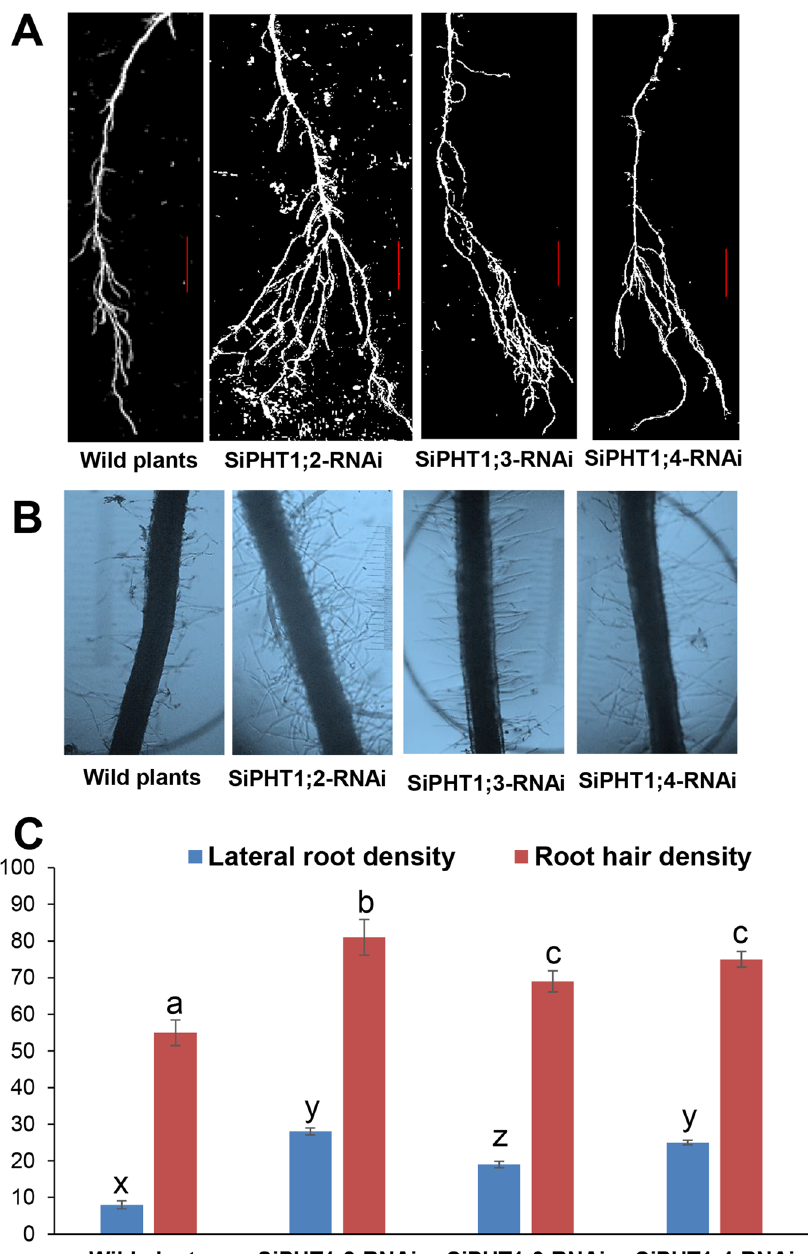
Figure 6. Analysis of root morphology in the 3 RNAi lines and wild plants grown under low Pi (10 µ M) on hydroponics. Whole root images showing the lateral root formation in wild type and 3 RNAi lines grown after 4 weeks ( A ) (bar = 1 cm), root hair images of wild type plant and 3 RNAi lines after 4 weeks of growth ( B ), measurement of lateral root density per cm of root and root hair density per 10 µ M of root in seedlings of wild type plants and 3 RNAi lines grown under low Pi on hydroponics for 4 weeks ( C ). Values are expressed as mean ± SD of 3 replicates ( n = 3 ). Values followed by the same letter are not significantly different ( P > 0 . 001 ) (separately for lateral root density shoot and root hair